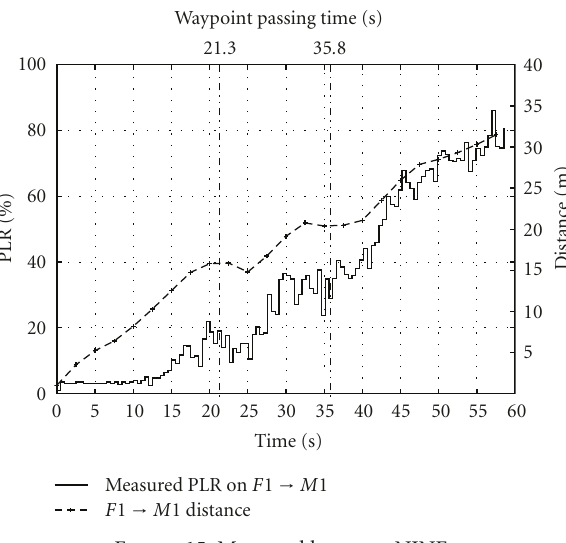
Figure 15: Measured losses on